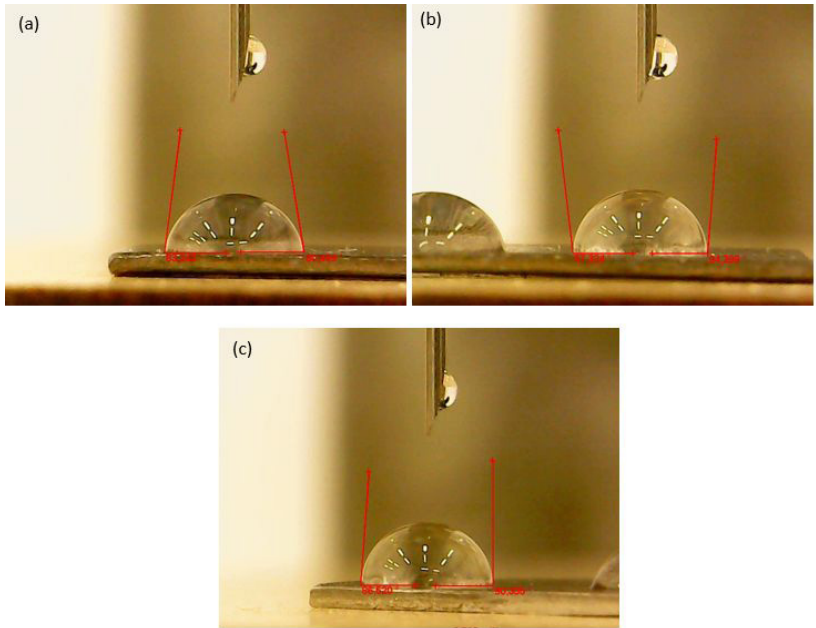
Figure 10. Wettability angle of the sample heat treated at 595 ºC; (a) Drop 1, (b) Drop 2 and (c) Drop